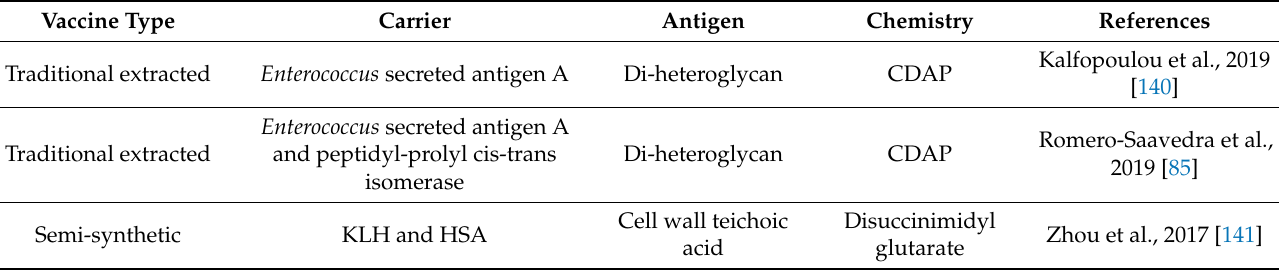
Table 8. Carbohydrate conjugate vaccines targeting Enterococcus faecium